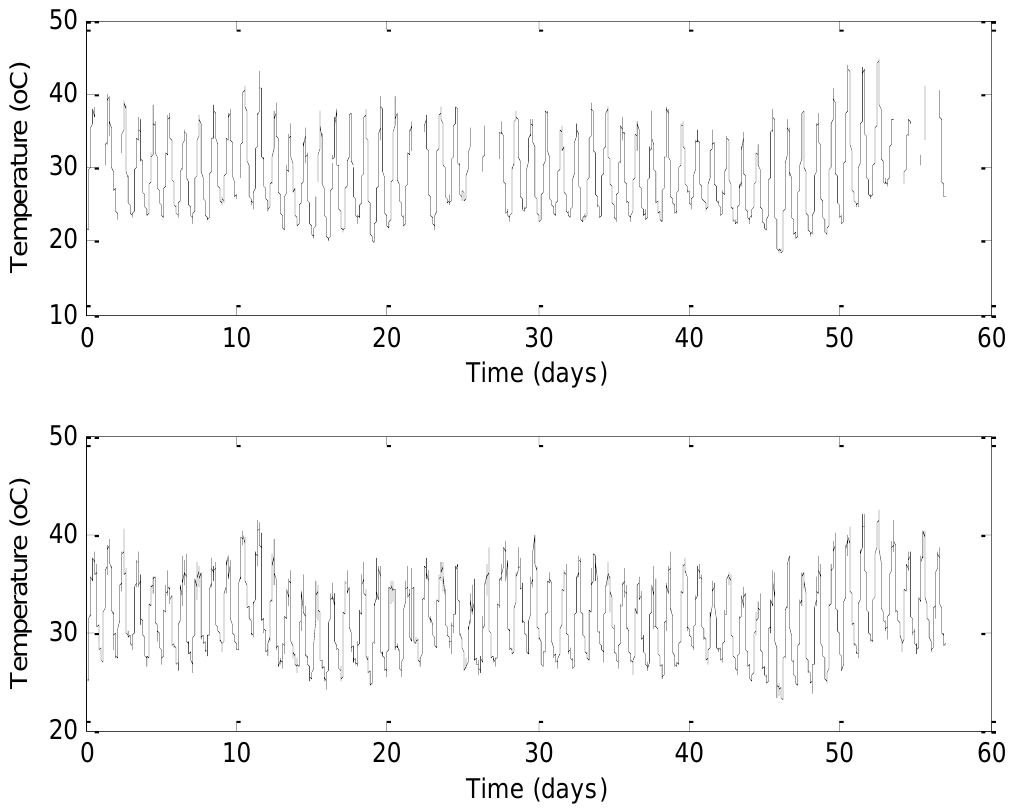
Figure 1. Air temperature values, measured by an online environmental monitoring system. ( Top panel corresponds to time series A, bottom panel to time series B).